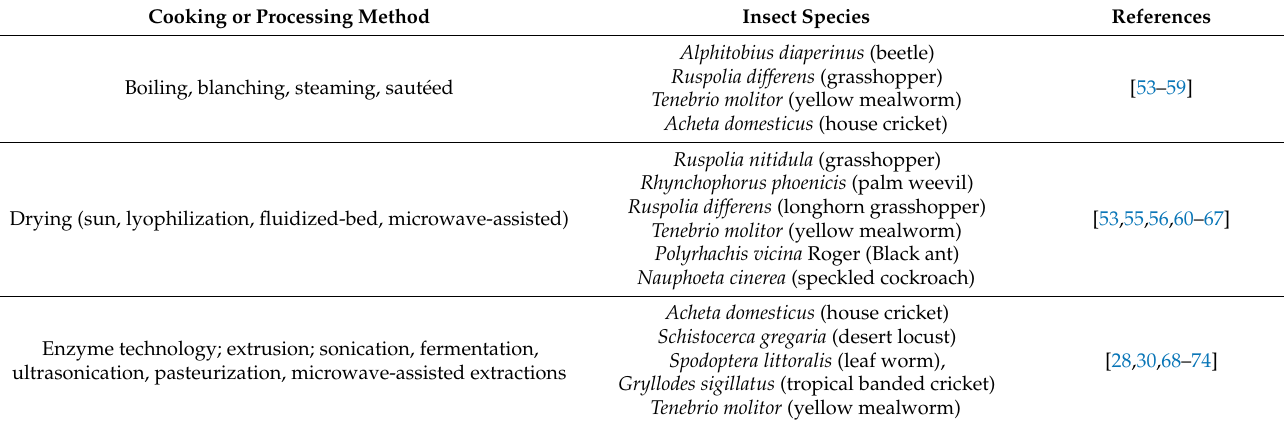
Table 2. Summary of most common cooking and commercial processing methods reported in the literature for edible insects (adapted from